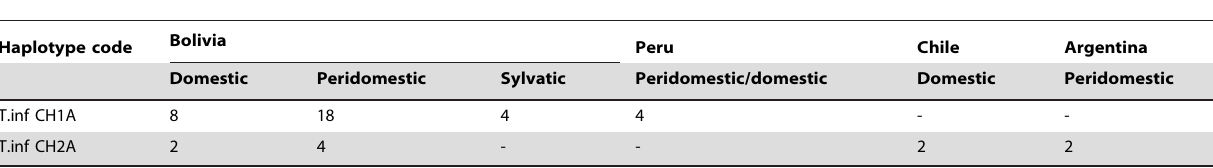
Table 2. Haplotype distribution of 44 T. infestans specimens analysed according to their geographical origin and ecotope.